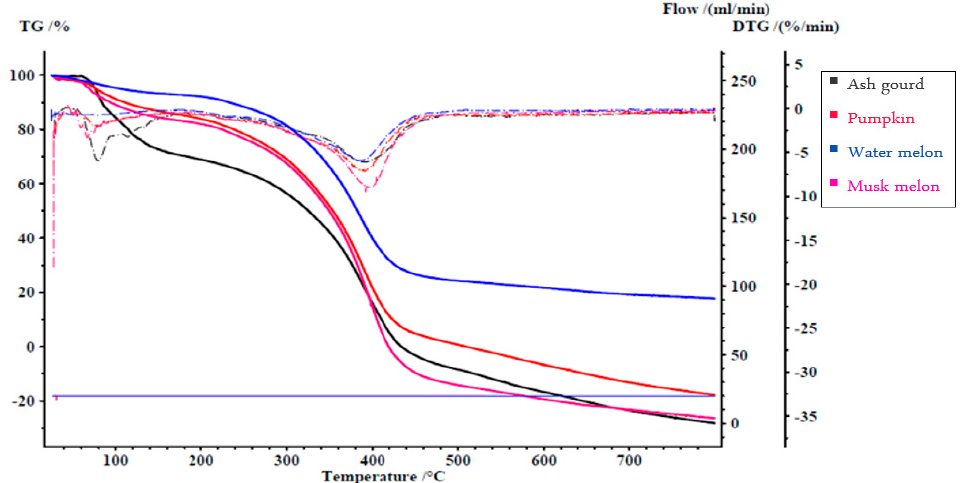
Figure 4. Thermal degradation profile by thermogravimetric and derivative thermogravimetric analysis (TGA and DTG).